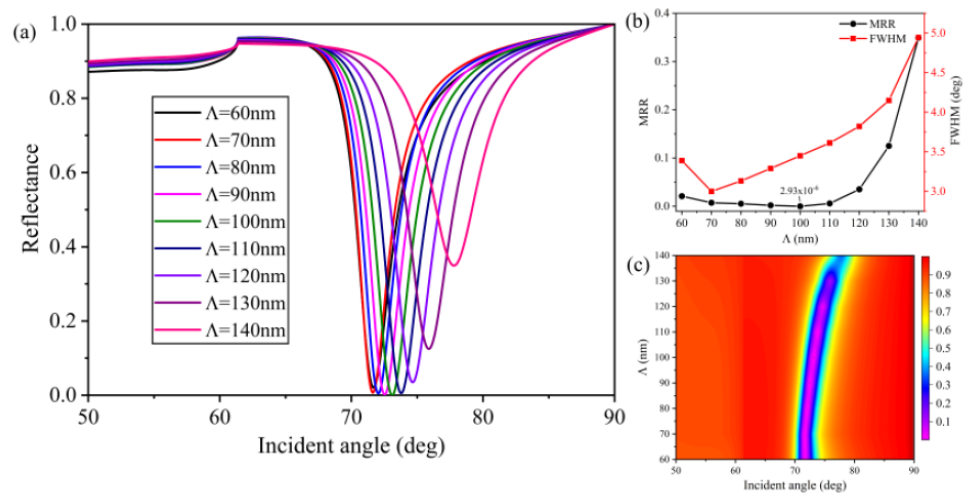
Figure 6. Influence of the grating period ( Λ ) on reflectance: ( a ) SPR curves of various grating periods; ( b ) MRR and FWHM as a function of Λ ; ( c ) contour plot of the reflectance ( T = 15 nm, m = 10 nm, h = 50 nm, w = 50 nm, and L = 1).